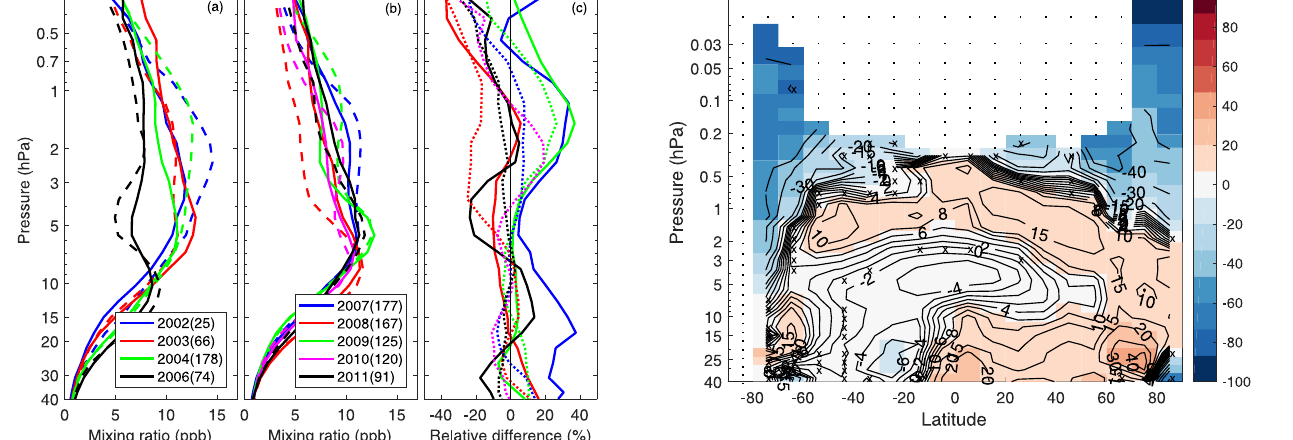
Figure 8. NO 2 yearly median mixing ratio profiles and median relative differences from GOMOS Sirius occultations and from paired WACCM profiles from 2002 to 2011 in the 40–60 ◦ S lat- itude band. Occultations take place during late August to mid- September. The vertical axis is pressure. (a, b) GOMOS profiles (solid lines) and WACCM profiles (dashed lines). The colour cod- ing in the legend shows the measurement year and the number of measurements is in parentheses. (c) Relative median difference WACCM–GOMOS/median(GOMOS). The colour coding for (c) follows (a, b) , but 2007–2011 lines are dotted.